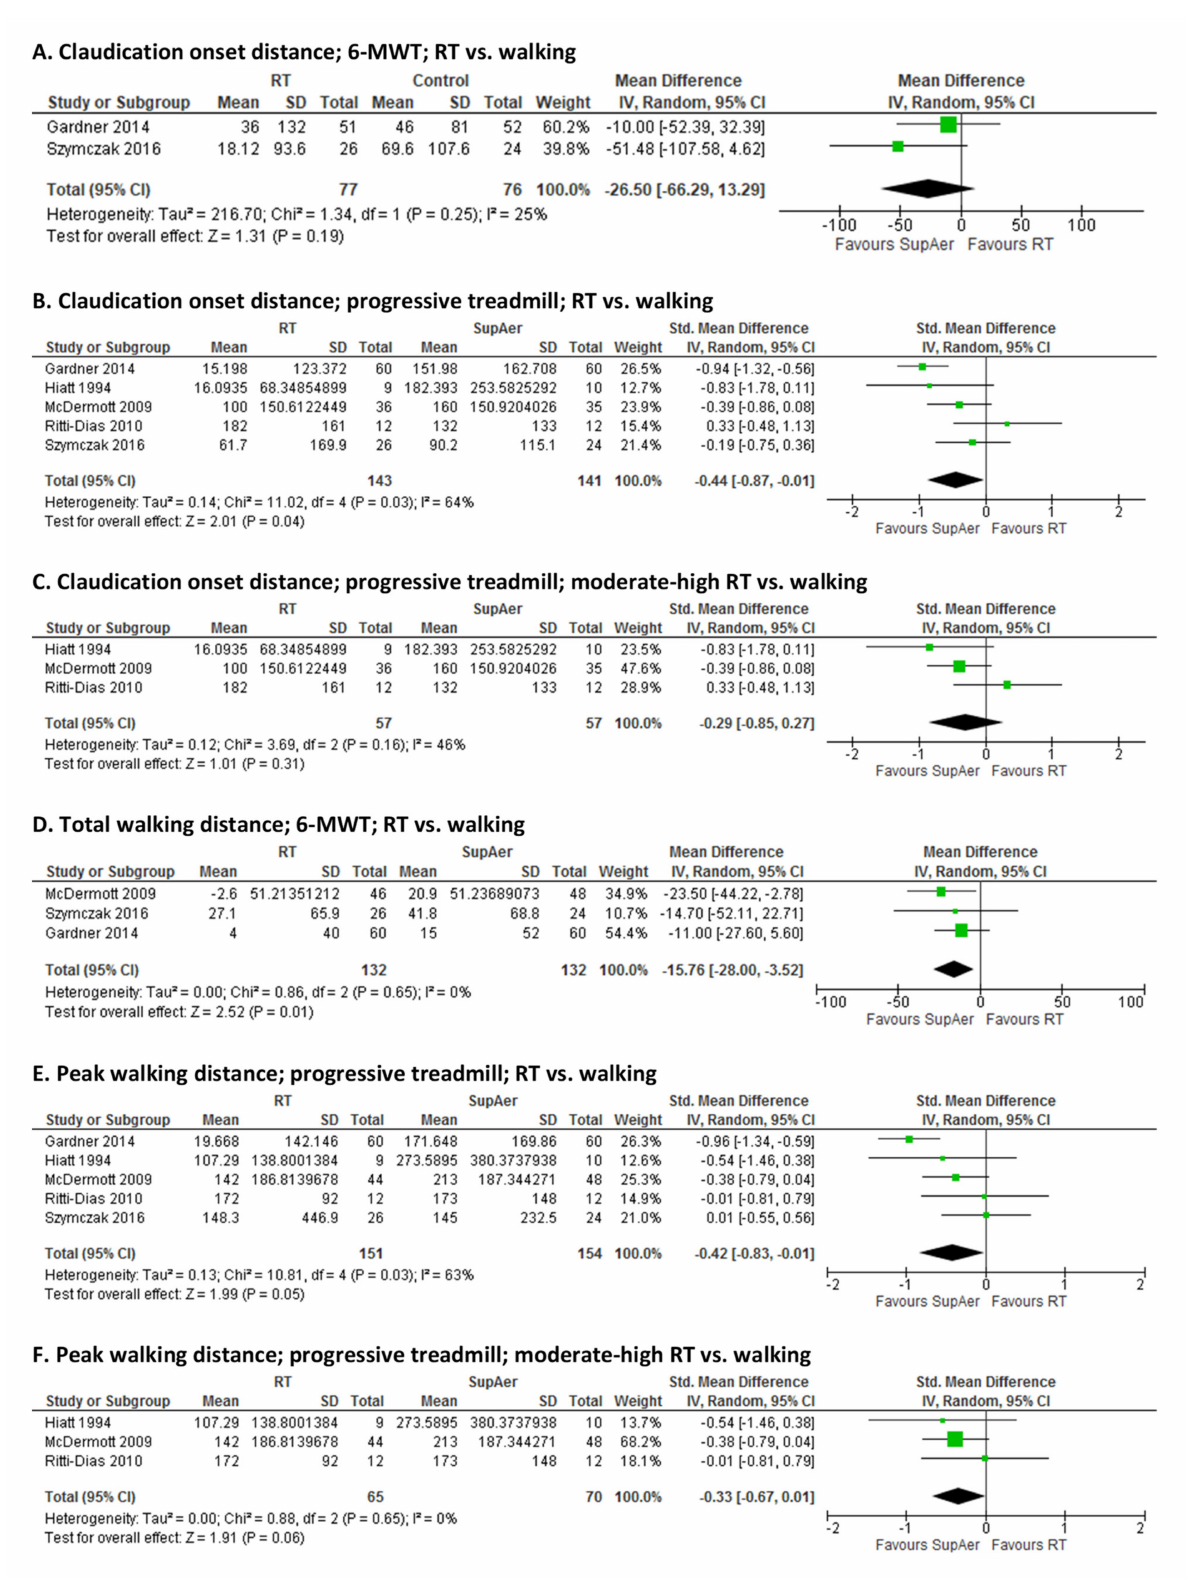
Figure 4. Pooled estimates and forest plots for supervised resistance training (RT) versus supervised walking on: clau- dication onset distance during a 6-min walk test (6-MWT) ( A ), progressive treadmill walking ( B ) progressive treadmill walking excluding mild intensity ( C ); total/peak walking distance during 6-MWT ( D ), progressive treadmill walking ( E ), progressive treadmill walking excluding mild intensity ( F